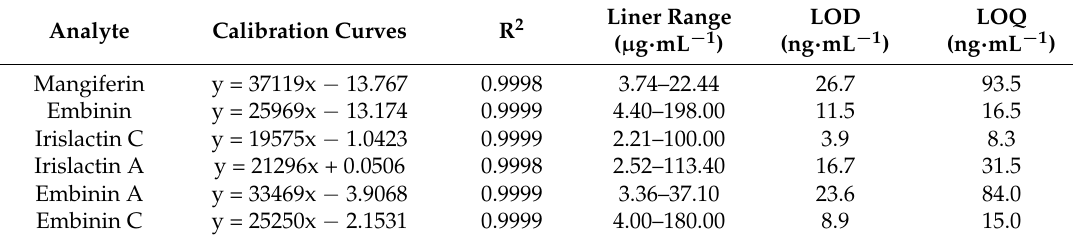
Table 2. Calibration curves, liner range, LOD and LOQ of six reference compounds.